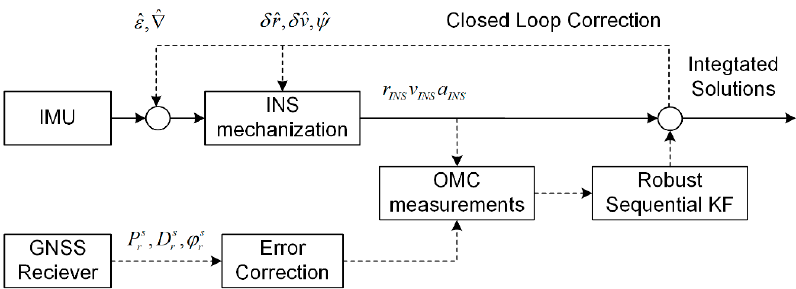
Figure 2. Tightly coupled Global Navigation Satellite System (GNSS) / Inertial Navigation System (INS) integration through a robust sequential Kalman Filter (KF).